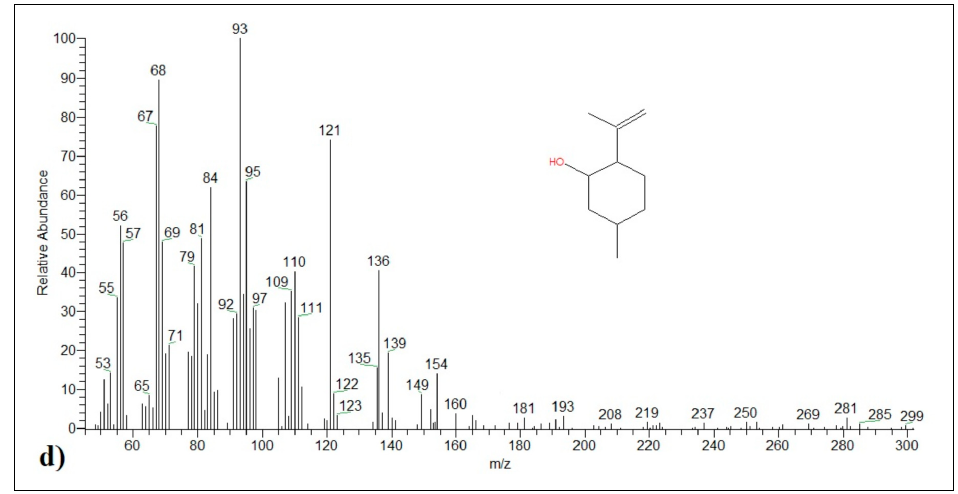
Figure 4. The 70 eV mass spectrum of D -limonene ( a ), γ -terpinene ( b ), β -pinene ( c ), and isopregol ( d ) components of Corymbia citriodora leaves’ recovery oil.